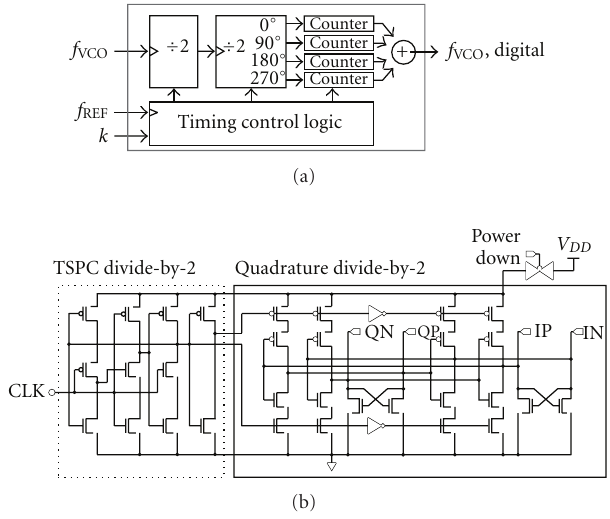
Figure 11: (a) Detail block diagram of the FDC. (b) Circuit schematic of quadrature-phase predivider having division ratio of 4.